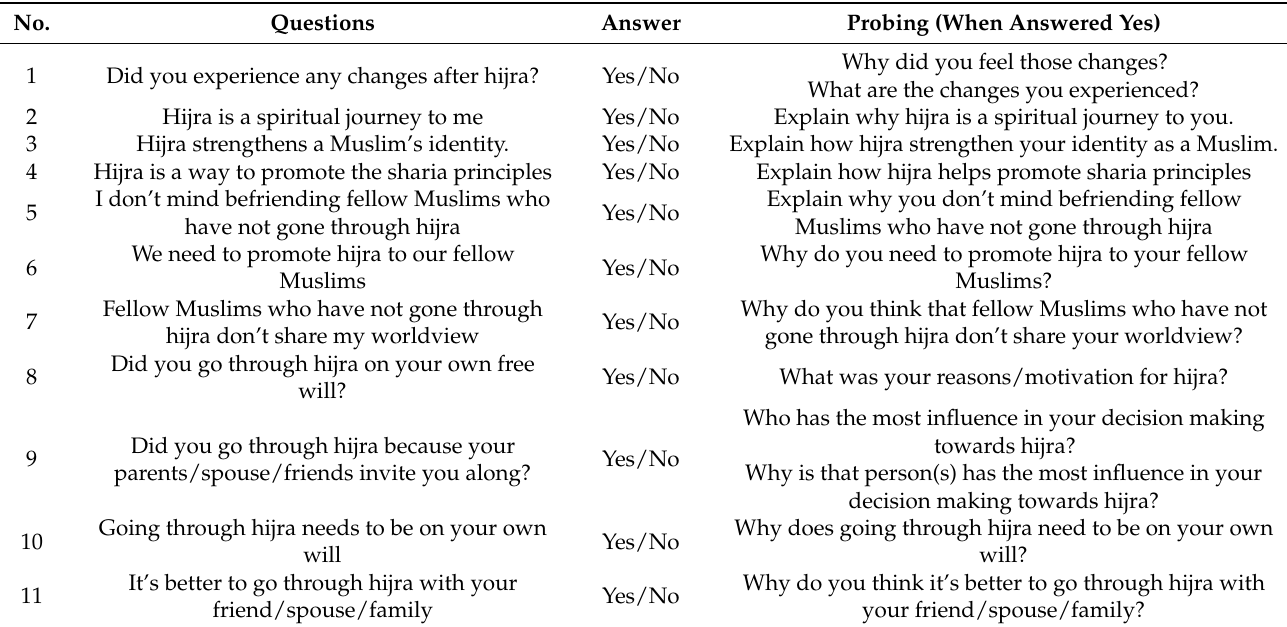
Table 2. Open-ended questionnaire